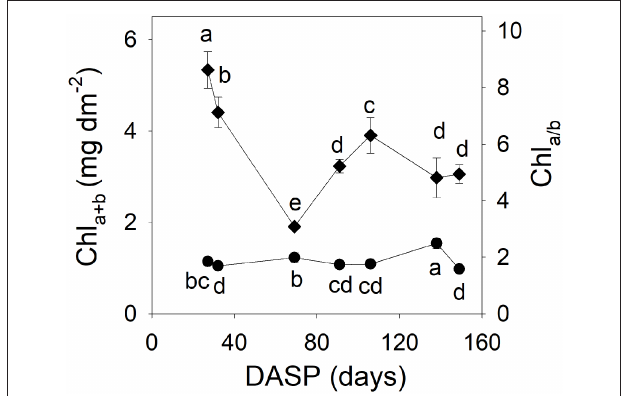
FIGURE 5 | Total chlorophyll content Chl a + b (left vertical axis, diamonds) and Chl a / b ratio (right vertical axis, circles) in sarcotesta of seeds of Torreya grandis cv. “Merrillii” during seed development in 2015. Different letters denote significant differences at P ≤ 0.05 level. n = 4 trees. DASP, days after seed protrusion.